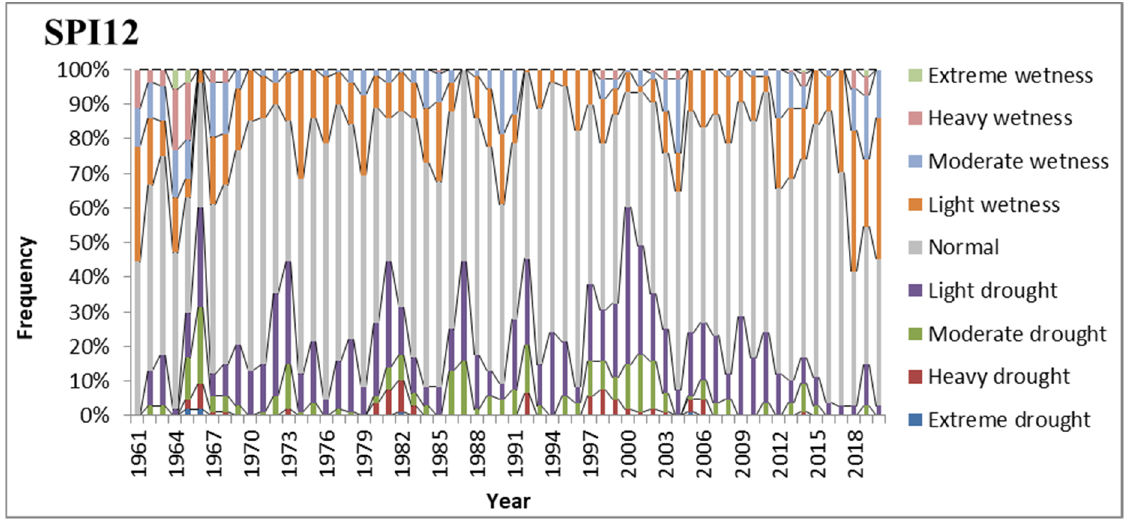
Figure 3. Frequency of different degrees of drought and wetness in the nine provinces and regions of the Yellow River basin from 1961 to 2020.